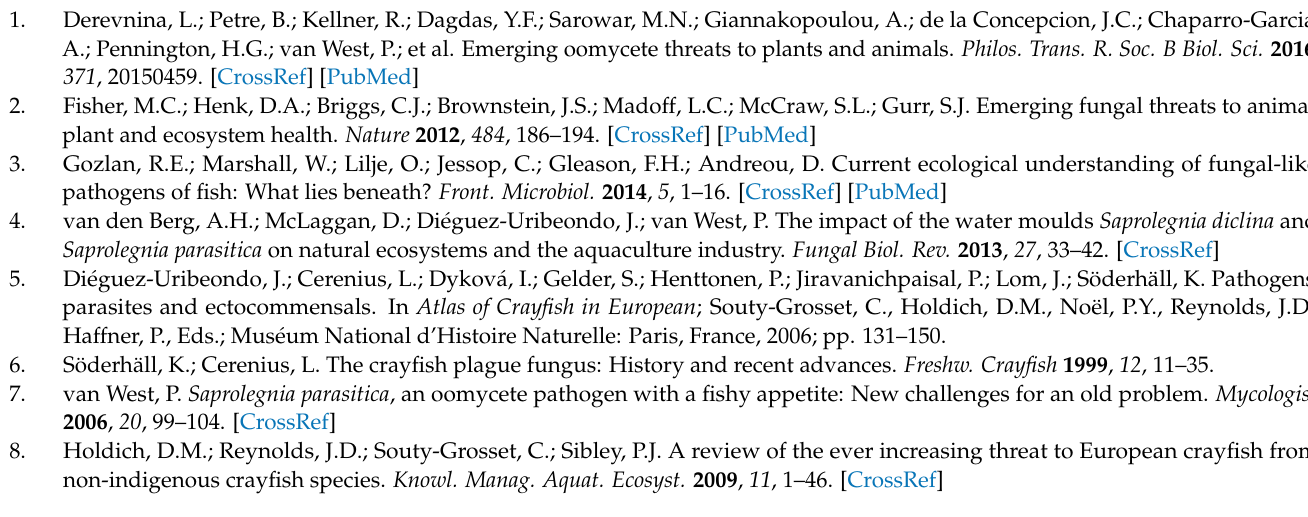
Table S2: Physico-chemical parameters of the collected water samples and the average number of zoospores obtained; Table S3: Correlation matrix describing the relationship between sporulation efficiency of A. astaci and S. parasitica (response variable) and physico-chemical parameters of water (explanatory